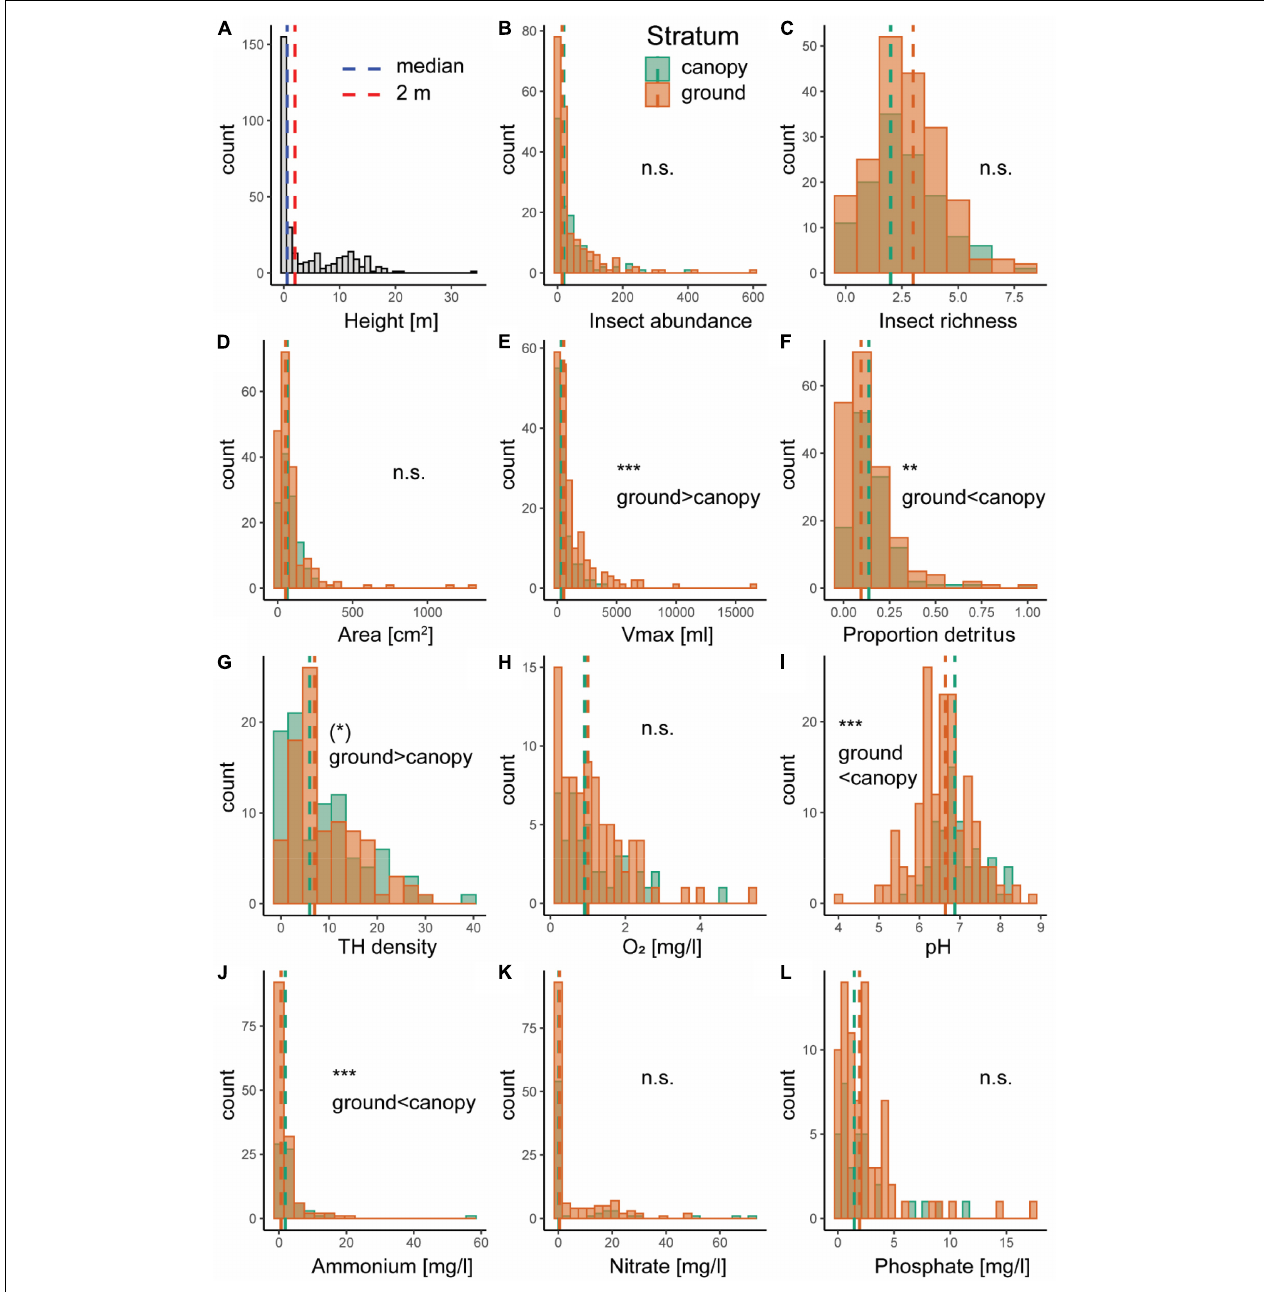
FIGURE 2 | Histograms of tree-hole height (A) , insect abundance (B) , insect species richness (C) , tree-hole opening area (D) , tree-hole maximum volume (Vmax; E ), total amount of detritus relative to tree-hole Vmax (proportion detritus; F ), plot-level tree-hole density (G) , and tree-hole water chemistry: dissolved oxygen concentration (O 2 ) (H) , pH (I) , ammonium concentration (J) , nitrate concentration (K) , and phosphate concentration (L) . Values for ground holes ( < 2 m height; orange) and canopy holes ( > 2 m height; green) in panels (B–L) are indicated by different colors, with median values shown as dashed lines. Asterisks indicate significance based on generalized (for insect abundance; Poisson distribution) or linear (all other variables) mixed effects models [(*) P = 0.051, ** P < 0.01, *** P < 0.001, n.s. not